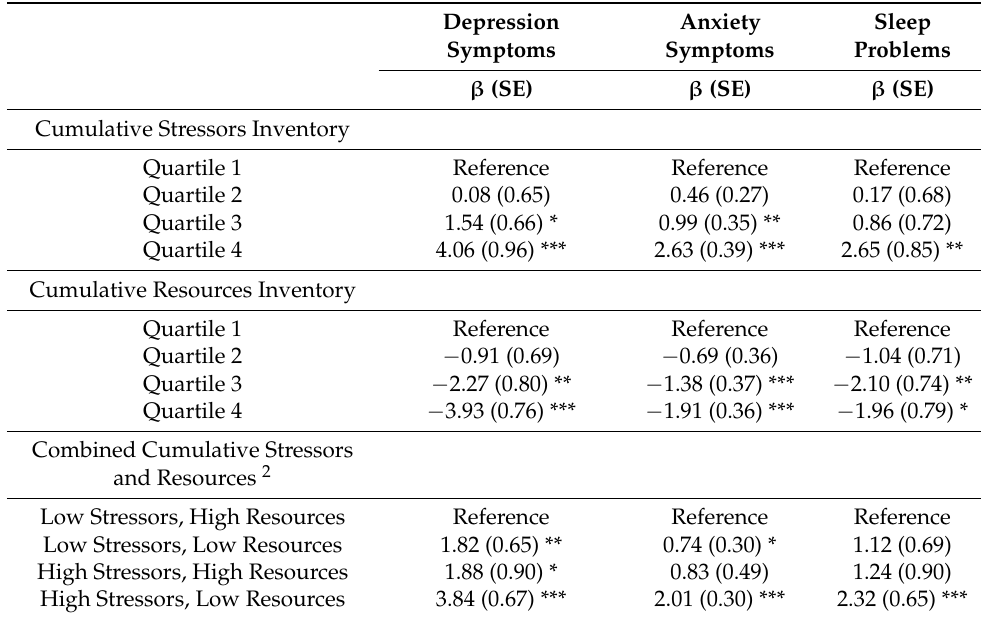
Table 5. Adjusted linear regression models to estimate the associations between stressors and resources inventories and caregiver outcomes (n = 169) 1